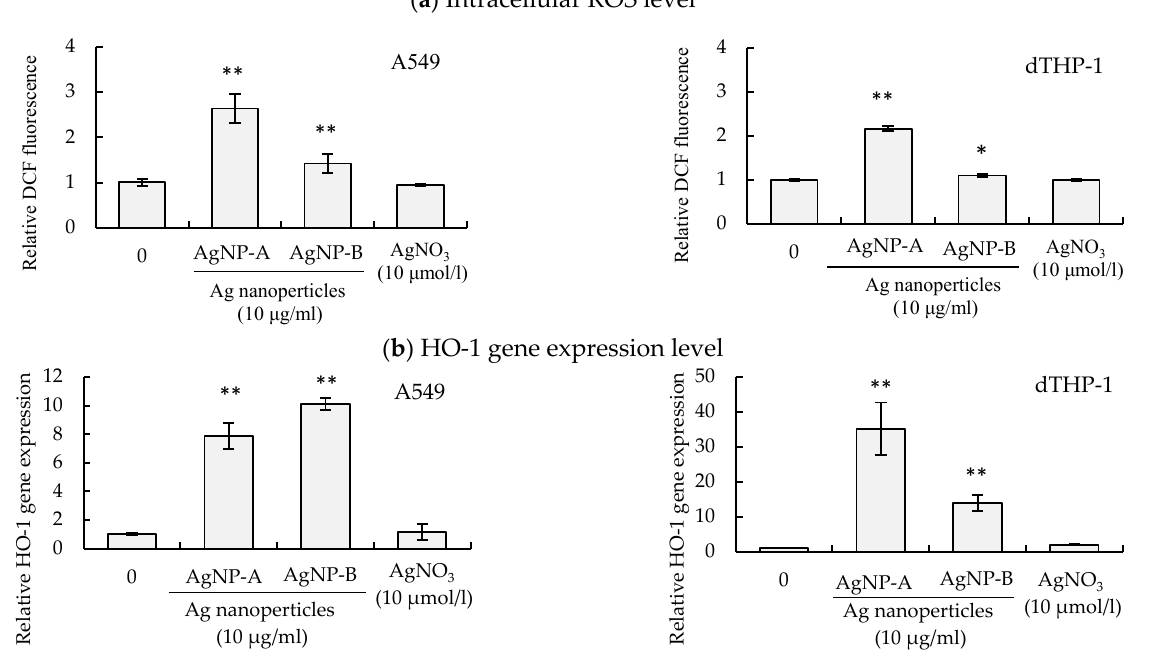
Figure 5. Effects of AgNPs and AgNO 3 on intracellular oxidative stress. ( a ) Intracellular ROS levels. A549 and dTHP-1 cells were treated with AgNP suspensions at 10 µ g/mL or AgNO 3 at 10 µ mol/L. After incubation for 24 h, intracellular ROS levels were measured by the DCFH assay. The value of DCF fluorescence in standardized untreated cells was 1. ( b ) HO-1 gene expression. A549 and dTHP-1 cells were treated with AgNP suspensions at 10 µ g/mL or AgNO 3 at 10 µ mol/L. After incubation for 24 h, HO-1 gene expression was determined by real-time PCR. ** p < 0.01, * p < 0.05 (vs. untreated cells, ANOVA and Dunnett’s test).